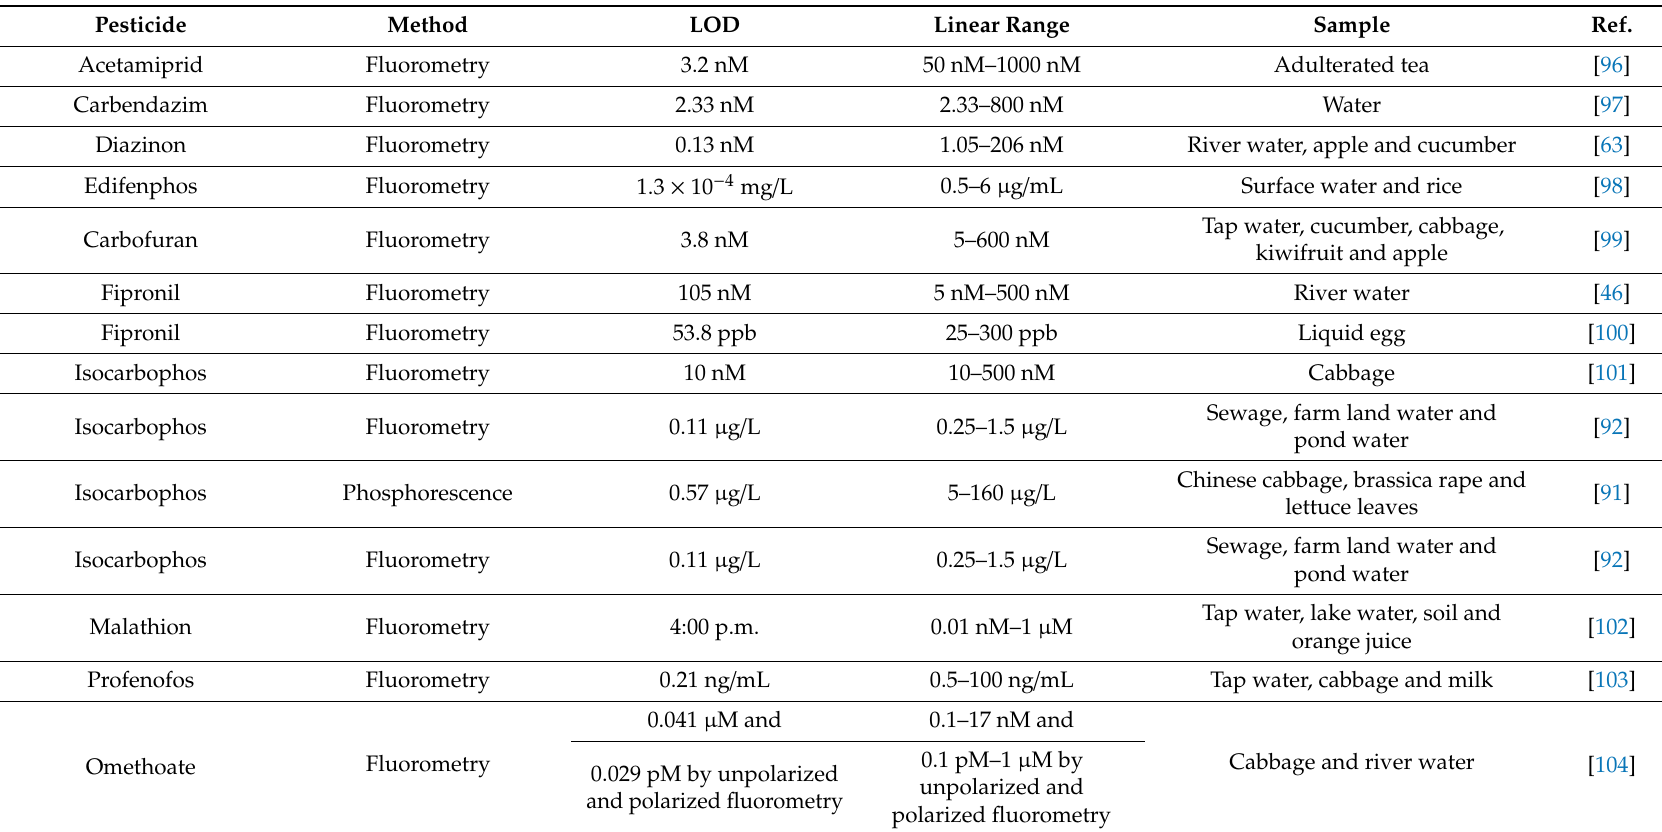
Table 3. Fluorescence-based aptasensors for pesticide